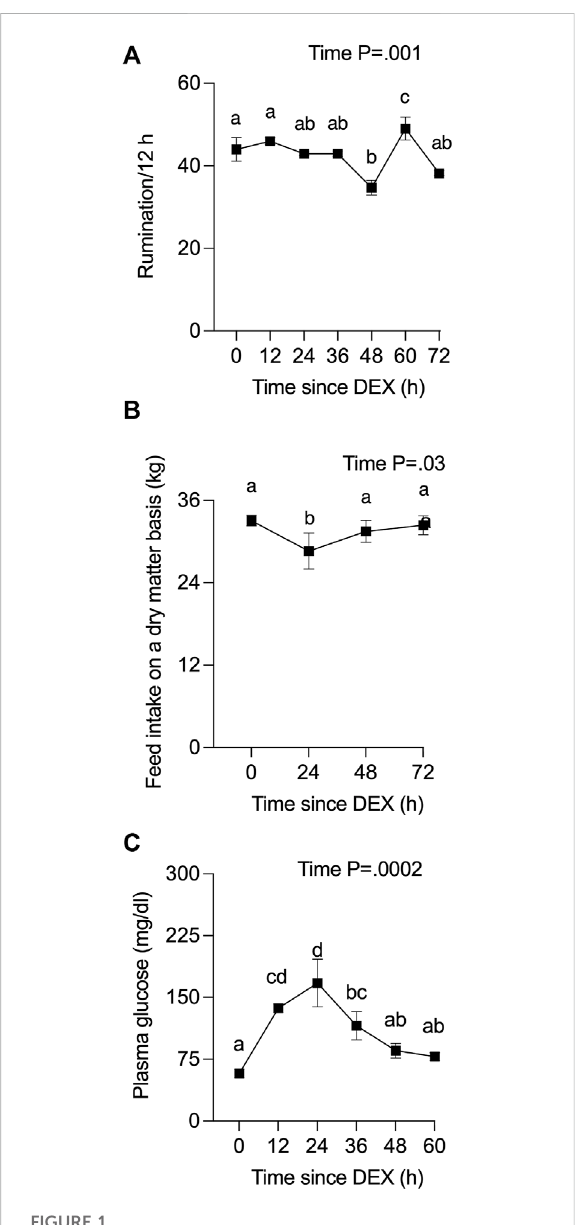
(A) rumination, (B) daily feed intake, and (C) plasma glucose. Time zero represents the average of 12 data points from − 24 to 0 h (h) for rumination, the average of − 24 and 0 h for feed intake, and the average of − 24, − 12, and 0 h for plasma glucose. Data are means ± SEM ( n = 3 cows). a, b, c, d Means with different superscriptsaredifferent( p < 0.05).The p -valueforthemaineffect of time is indicated on each panel when p <